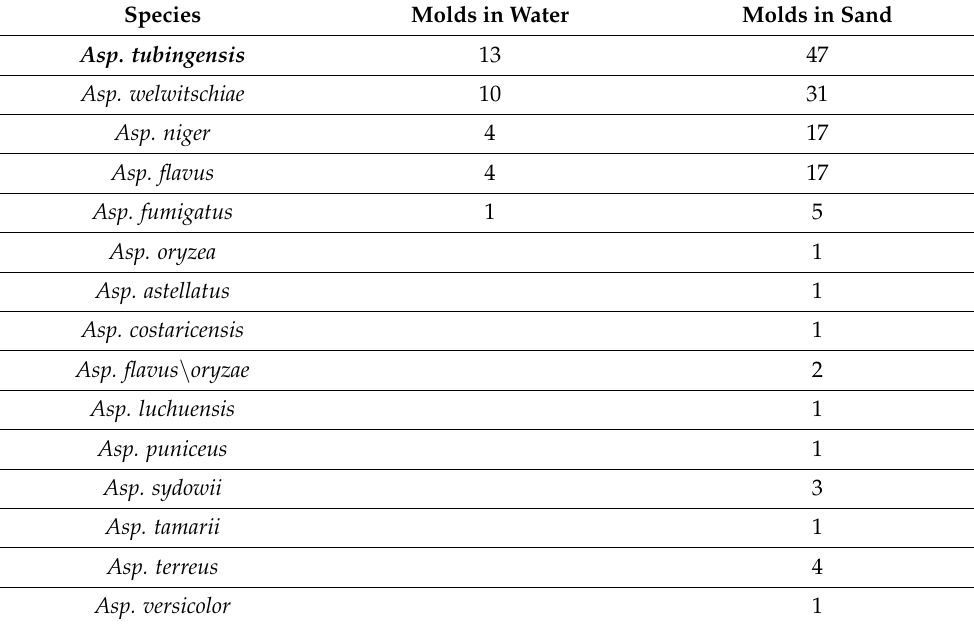
Figure 3. Molds in sand and in water. The Y-axis represents the number of isolates. Table 1. Number of isolates per mold species identified in water and sand. Species Molds in Water Molds in